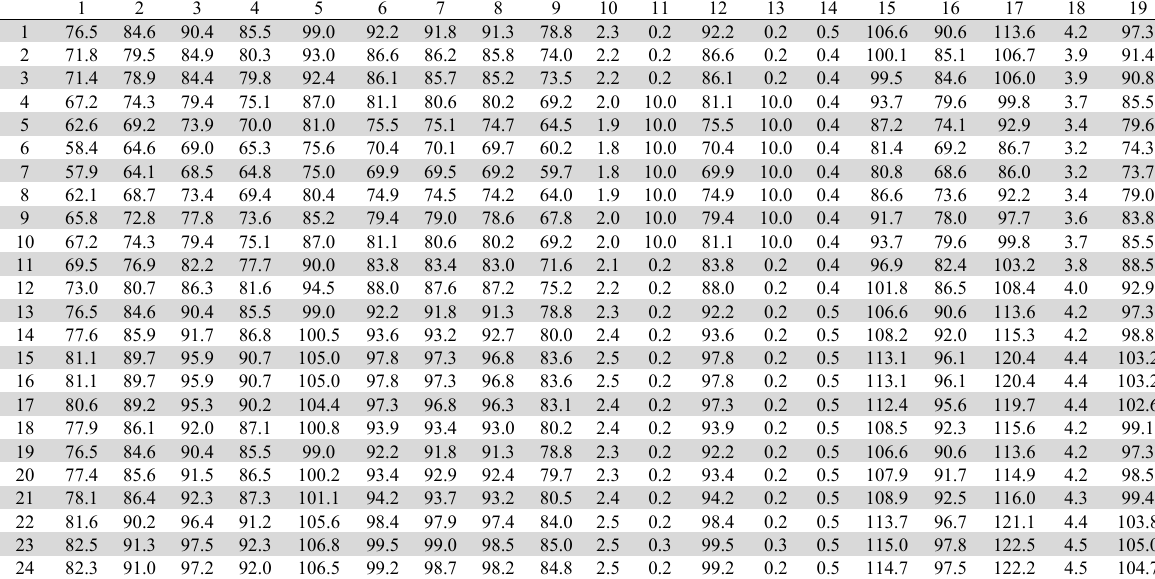
Hourly peer consumption (kWh). All test cases